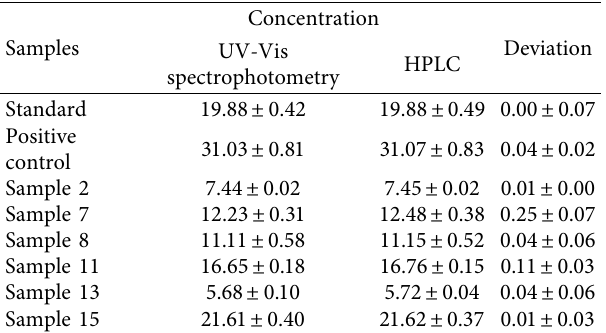
Table 2: Comparison of analysis of herbal samples with UV-Vis spectrophotometry and HPLC ( n �